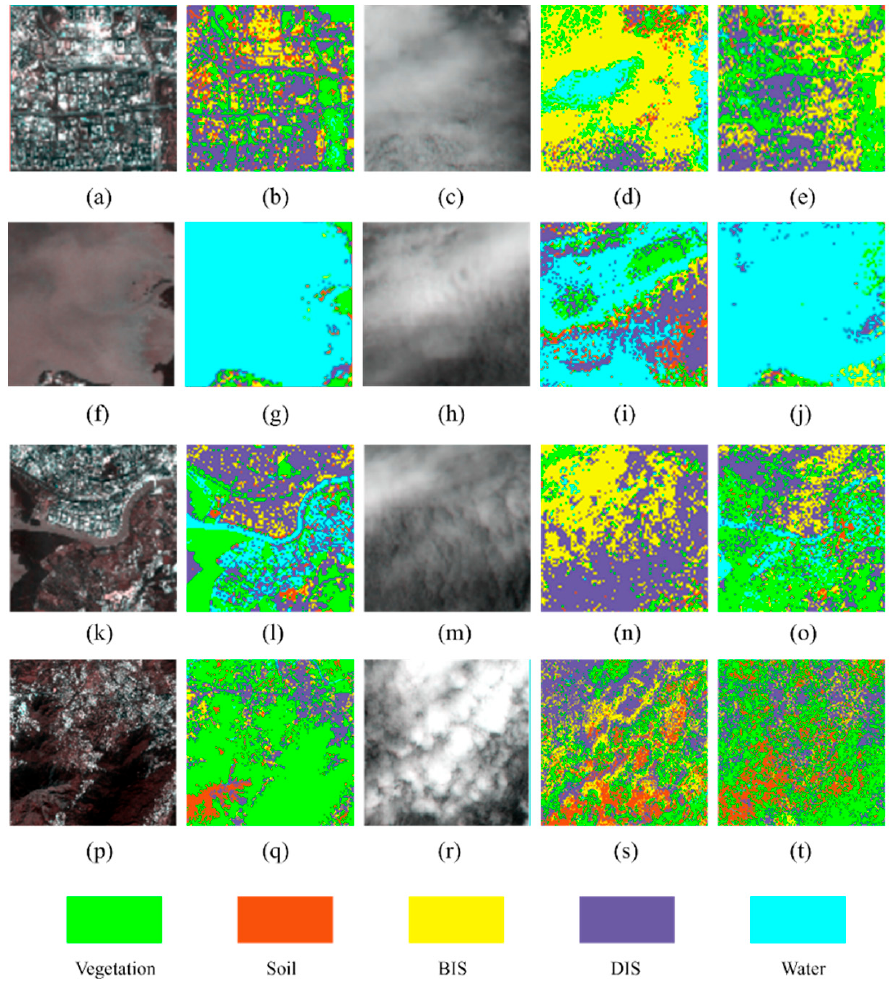
Figure 4. Detailed classification maps on cloud-free and cloud-covered images. ( a , f , k , p ) are the cloud-free images, ( b , g , l , q ) are classification maps of the cloud-free images, ( c , h , m , r ) are the cloud-covered images, ( d , i , n , s ) are the classification maps of the single cloud-covered images, and ( e , j , o , t ) are the classification maps of fused optical and SAR images.